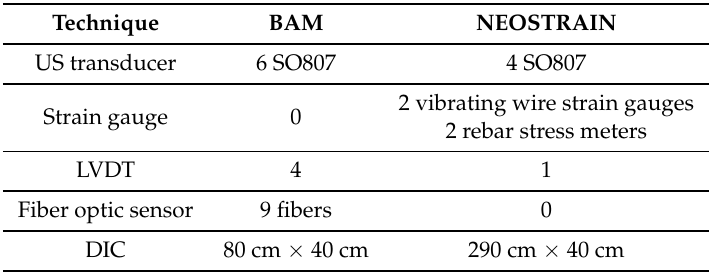
Table 1. Techniques and sensors used in two tests.